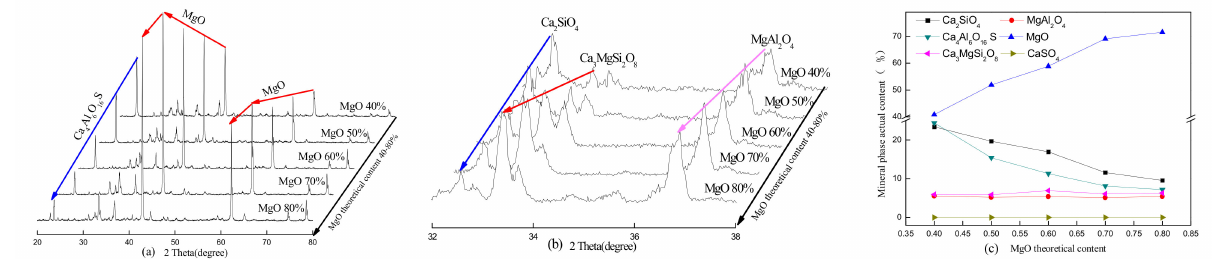
Figure 7. XRD patterns of the SAC-MKPC clinker with MgO theoretical content at 1350 ◦ C: ( a ) main phase; ( b ) minor phase; and ( c ) mineral phase actual content.